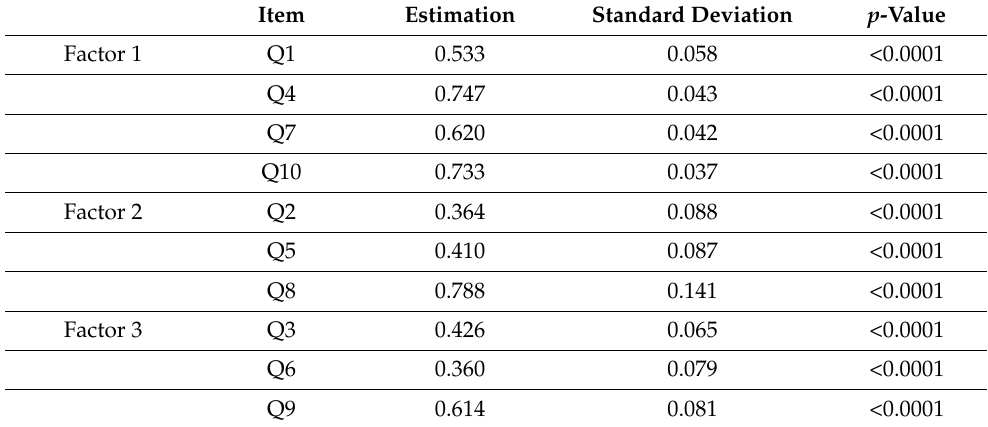
Table 7. Standardized estimators of loading coefficients of latent variables, medicine sector.